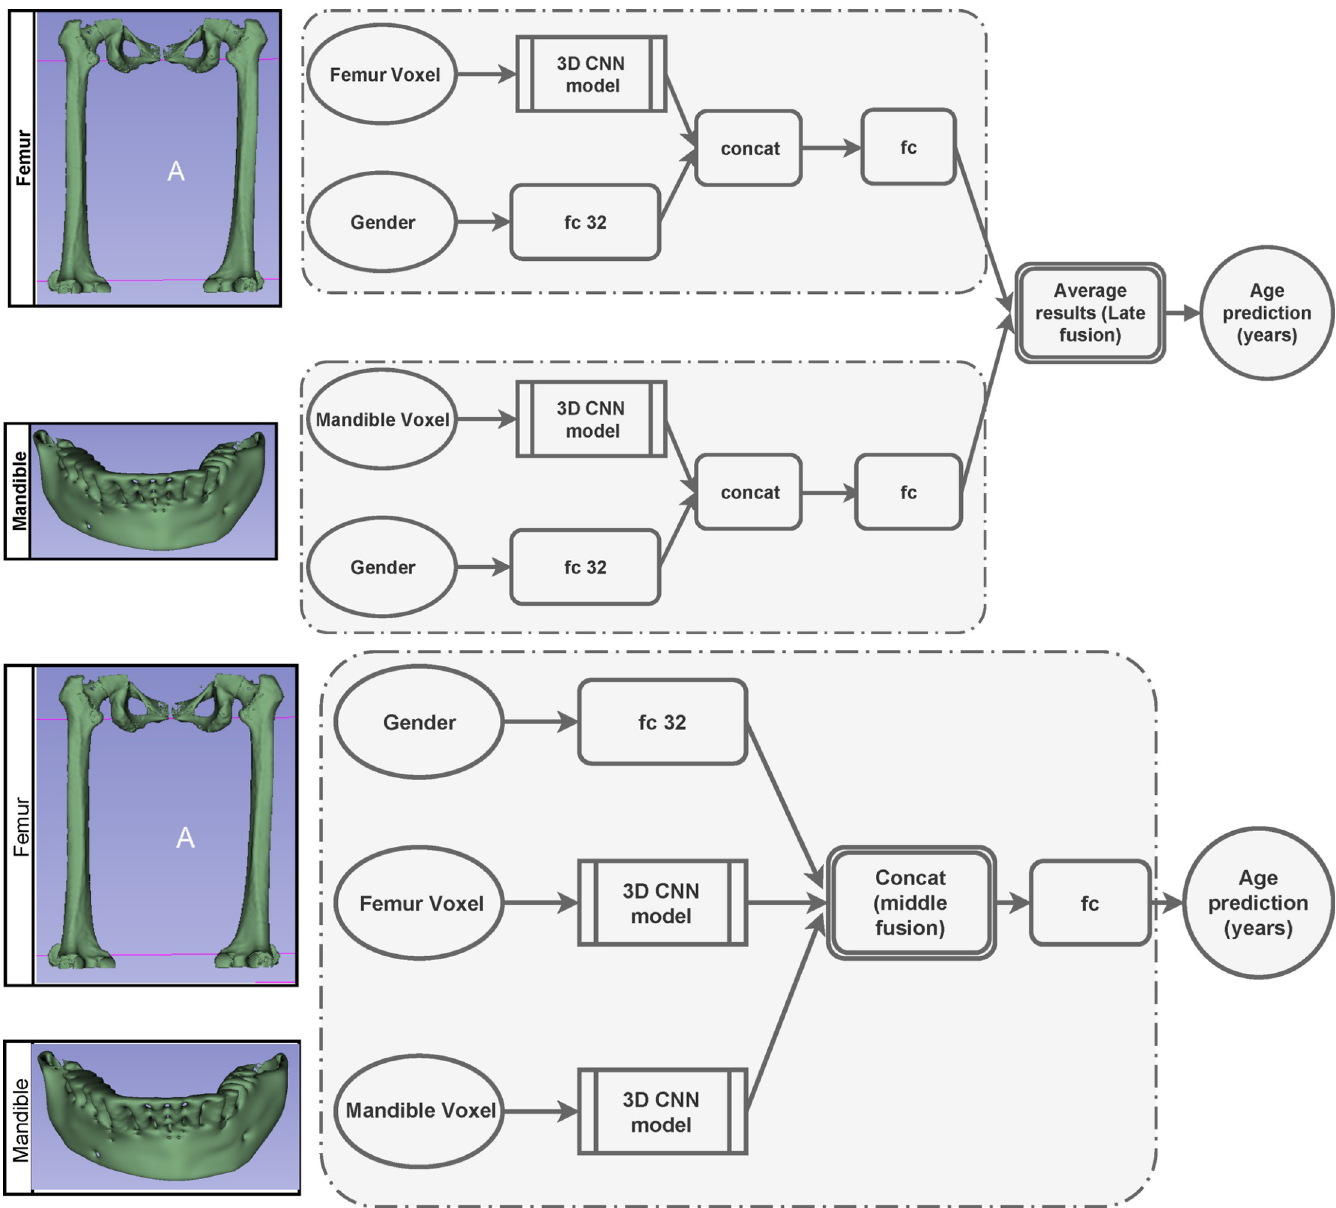
Fig 3. Overview of our age estimation architecture. 3D PMCT volumes of the femur and mandible are fed into the deep CNN, which then fuses their results to obtain the final precise prediction (years).